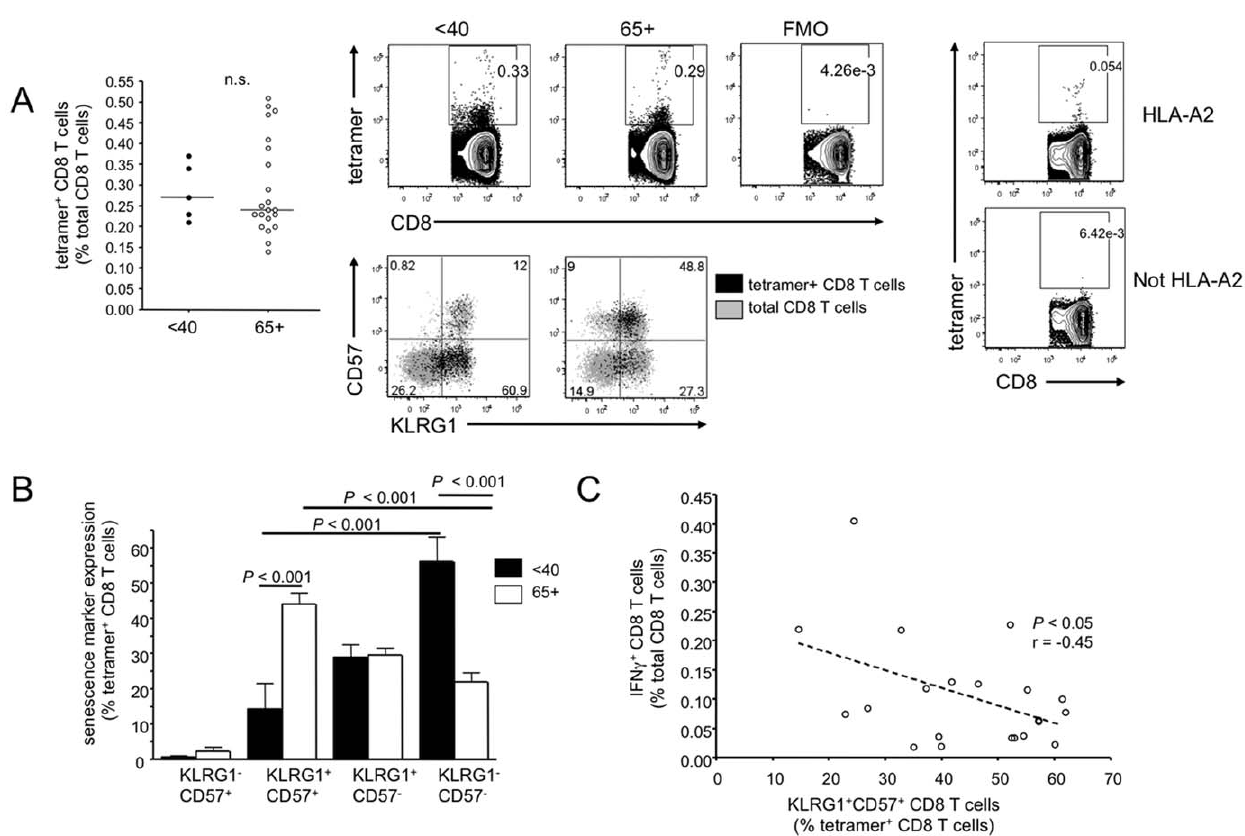
Figure 3. Influenza-specific T cells from older donors have a late effector phenotype and express markers associated with replicative senescence. Total unfractionated PBMC from HLA-A2 donors were stained directly ex vivo for the M1-specific T cell receptor by tetramer and for the markers KLRG1 and CD57. (A) Tetramer positive CD8 T cells from HLA-A2 positive young and older adults. Representative staining is shown for KLRG1 and CD57 in the tetramer positive subset overlaid on the total CD8 T cell population in a young and 65 + donor. The rightmost panels show A2/M1 tetramer staining on an A2 and a non-A2 donor, to confirm tetramer staining specificity. This control was repeated with 3 A2 positive and 3 A2 negative donors with similar results. (B) KLRG1 and CD57 phenotypes in the tetramer positive influenza-specific CD8 T cell population from under 40 and 65 + HLA-A2 positive donors. (C) Comparison of IFN c expression in CD8 T cells stimulated for 18 hours with PR8 and the relative proportion of tetramer positive CD8 T cells which co-express KLRG1 and CD57 directly ex vivo on a per-donor basis in HLA-A2 positive older (65 + ) donors.